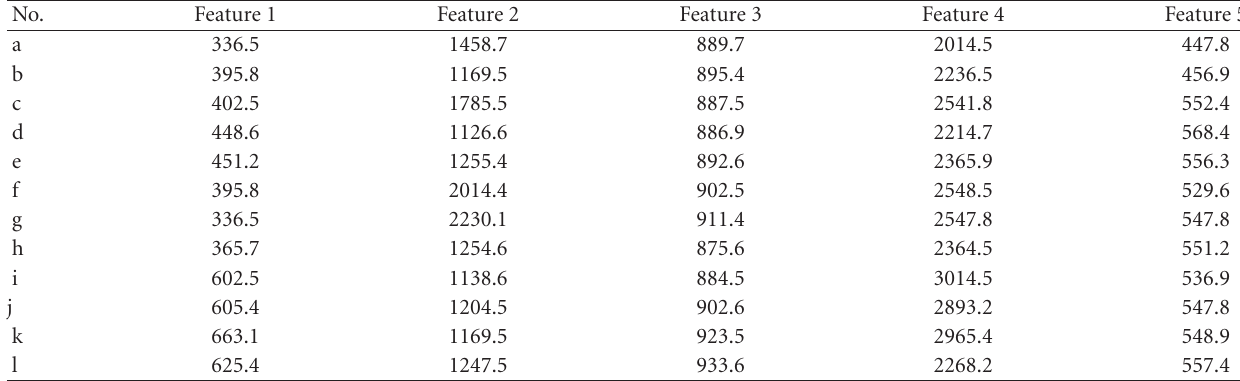
Table 4: Energy distribution surface features in energy optimization modeling